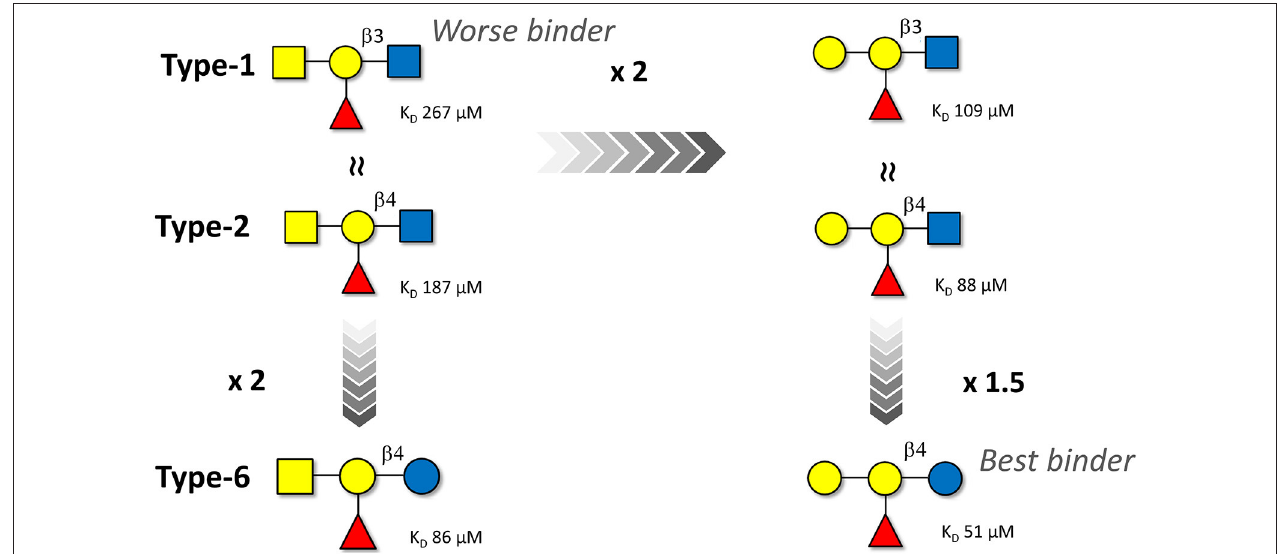
FIGURE 6 | Schematic representation of the affinity trends for the binding of the A and B blood group antigen tetrasaccharides (types-1, -2, and -6) to Gal-4N as deduced by ITC. The NMR-based data follow the same trend although the estimated binding affinities are ca. 1.5-fold weaker. The type-4 oligosaccharides are not displayed since their affinities are even weaker than those of the type-1